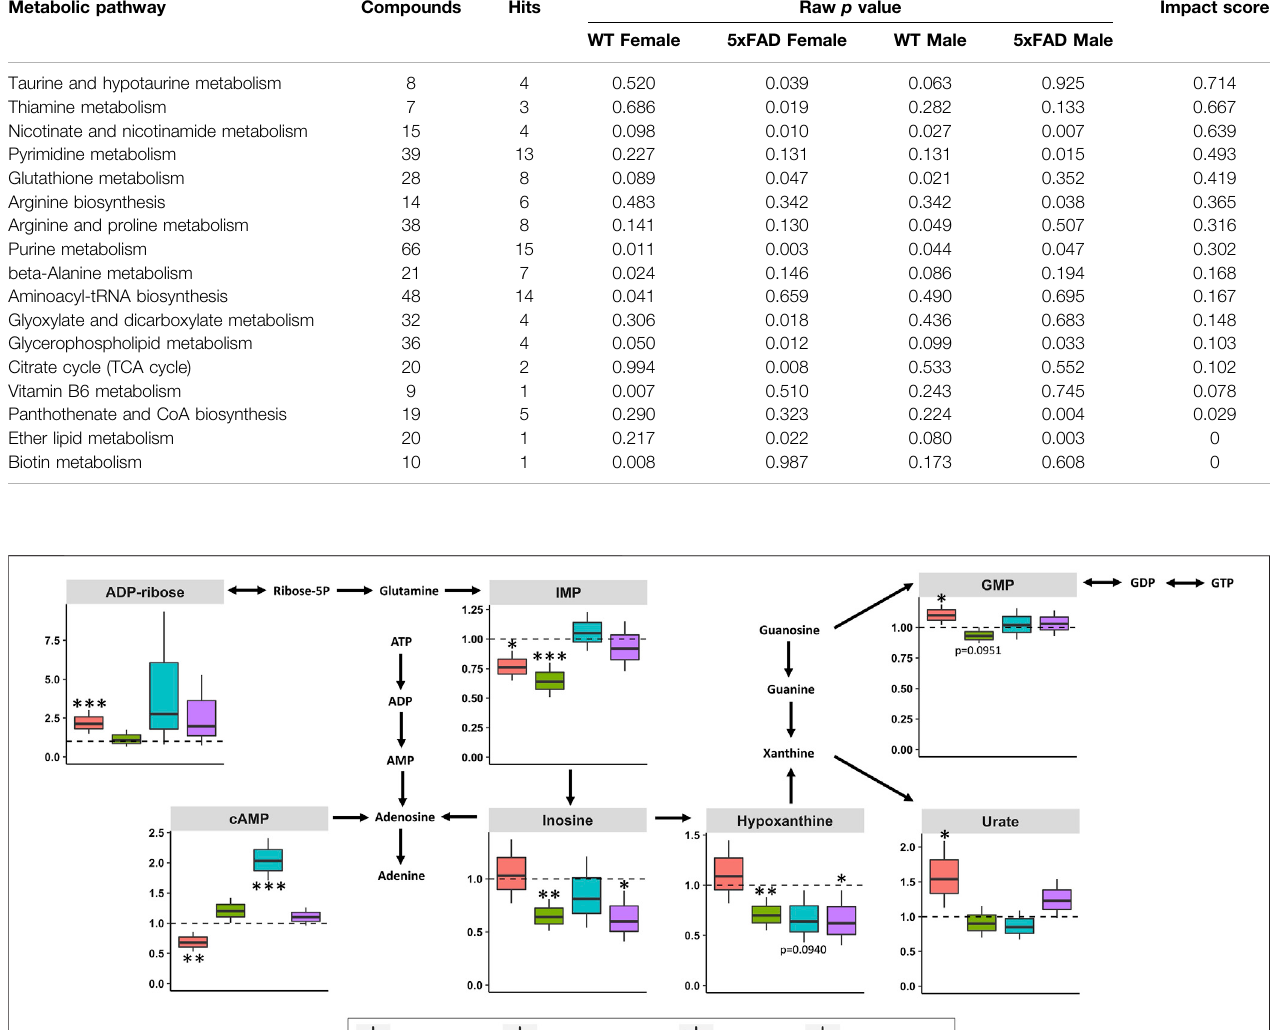
were signi fi cantly downregulated at all three dose levels ( Figure 6B ). In WT males, adenosine 3 ′ ,5 ′ -cyclic monophosphate and spermidine were signi fi cantly upregulated